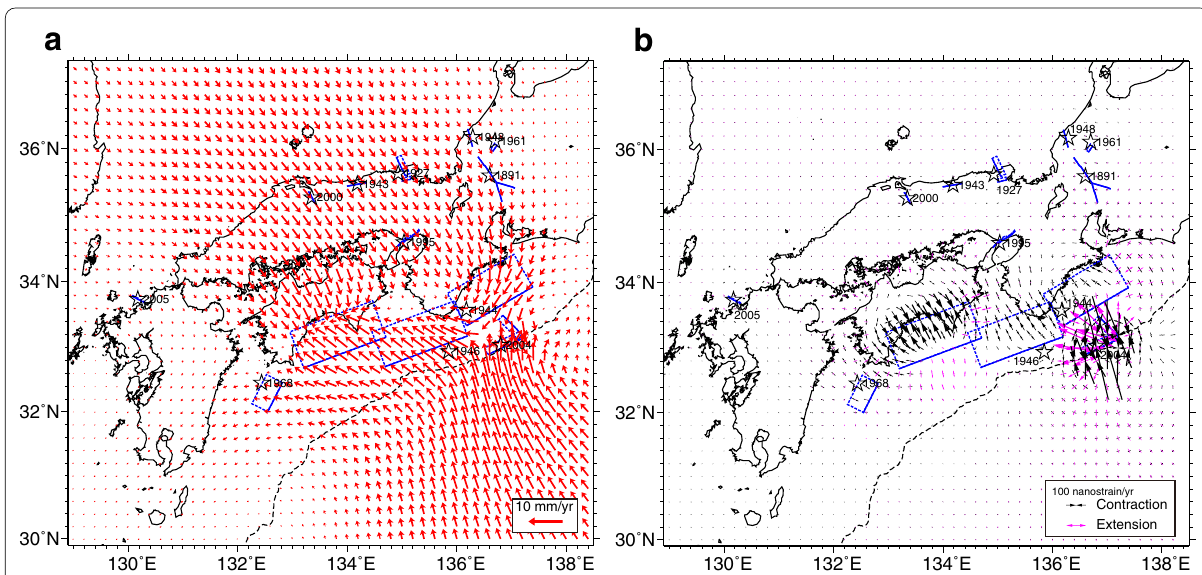
Fig. 6 Postseismic deformation predicted by viscoelastic relaxation of the 12 large earthquakes listed in Table 3. Blue rectangles and stars show rectangular fault models and epicenters of the earthquakes, respectively. 4-digit numbers represent the occurrence year of the earthquakes. a Velocity in 2007, and b strain rates in 2007